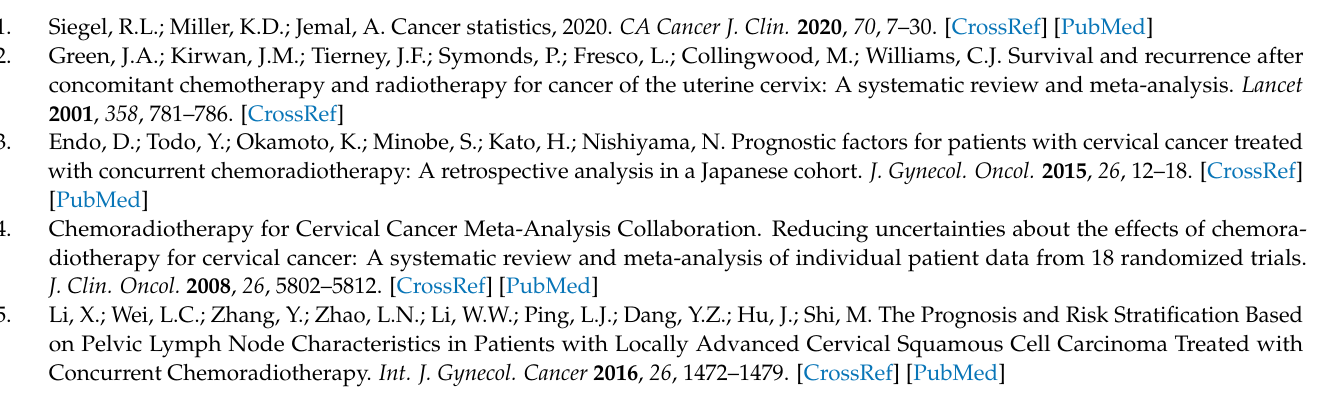
results about pretreatment FDG PET parameters as a continuous variable. Table S3: Summary of prognostic results about FDG PET parameters during treatment. Table S4: Information about the PET/CT technique and image analysis. Figure S1: Results for the primary SUV max for DFS. (A) Forest plots of the HRs for SUV max . (B) Begg’s funnel plot for SUV max . (C) Sensitivity analysis of the influence of each individual study on the pooled HR for SUV max . Figure S2: Results for the nodal SUV max for DFS. (A) Forest plots of the HRs. (B) Begg’s funnel plot. (C) Sensitivity analysis of the influence of each individual study on the pooled HR. Figure S3: Results for the primary SUV max for OS. (A) Forest plots of the HRs. (B) Begg’s funnel plot. (C) Sensitive analysis of the influence of each individual study on the pooled HR. Figure S4: Results for the primary SUV mean , TLG, and nodal SUVmax, as well as for OS. (A) Forest plots of the HRs with primary SUV mean . (B) Forest plots of the HRs with primary TLG. (C) Forest plots of the HRs with nodal SUV max